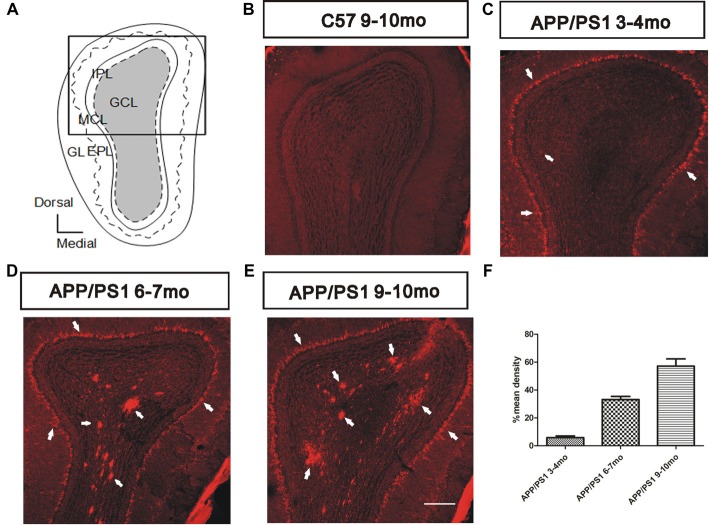
Spatiotemporal pattern of amyloid-β (Aβ) depositions in the olfactory bulb (OB) of APP/PS1 mice. (A) Image of the OB coronal plate indicating the bulbar cell layers [glomerular layer (GL), external plexiform layer (EPL), MCL, inner plexiform layer (IPL) and granule cell layer (GCL)]. (B) No Aβ was observed in the OB of C57 mice at 9–10 months of age. (C–E) Representative images of Aβ staining (white arrows) in the OB of APP/PS1 mice at 3–4, 6–7 and 9–10 months of age. Scale bars = 200 μm in (E; applies to B–E). (F) The mean percentage density of deposited Aβ was elevated in the GCL within the OB cell layers of APP/PS1 mice. The error bars indicate the SEMs.